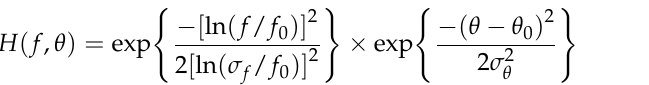
Figure 2. Image results by EdgeBoxes: ( a ) edge image; ( b ) region proposal.